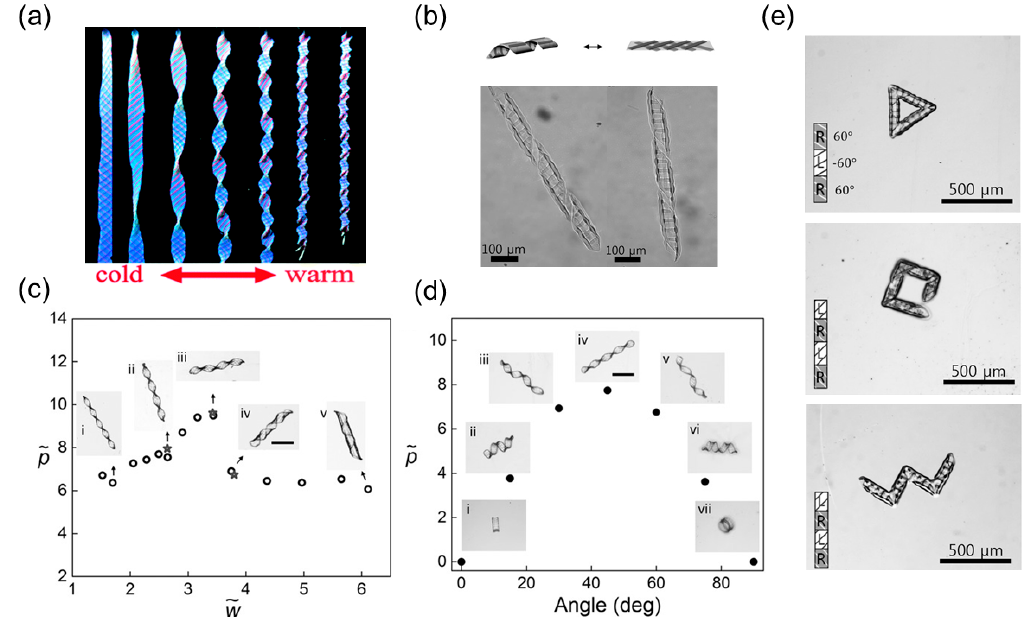
Figure 4. Thermally responsive hydrogel-based helical structures mimicking Bauhinia variegata . ( a ) Transition from a twisted helicoid to a spiral helical shape as the shrinkage ratio of hydrogel increases with rising temperature; ( b ) Schematic illustration of helical transformation in a tri-layer hydrogel composite (top) and a helical hybrid hydrogel with right-handedness (bottom left) or left-handedness (bottom right) under an optical microscope; ( c ) The relationship between the helix pitch and the dimensionless width; ( d ) The relationship between the helix pitch and the reinforcement angle; ( e ) Complex shapes obtained by connecting helices with different lengths or handedness, including triangle (top), square (middle) and zigzag (bottom). The insets are 2D precursors of the hydrogel sheets during photo-crosslinking. ( a ) is from [28], reprinted with permission from The Royal Society of Chemistry; ( b – e ) are from [29], reprinted with permission from 2017 Wiley.